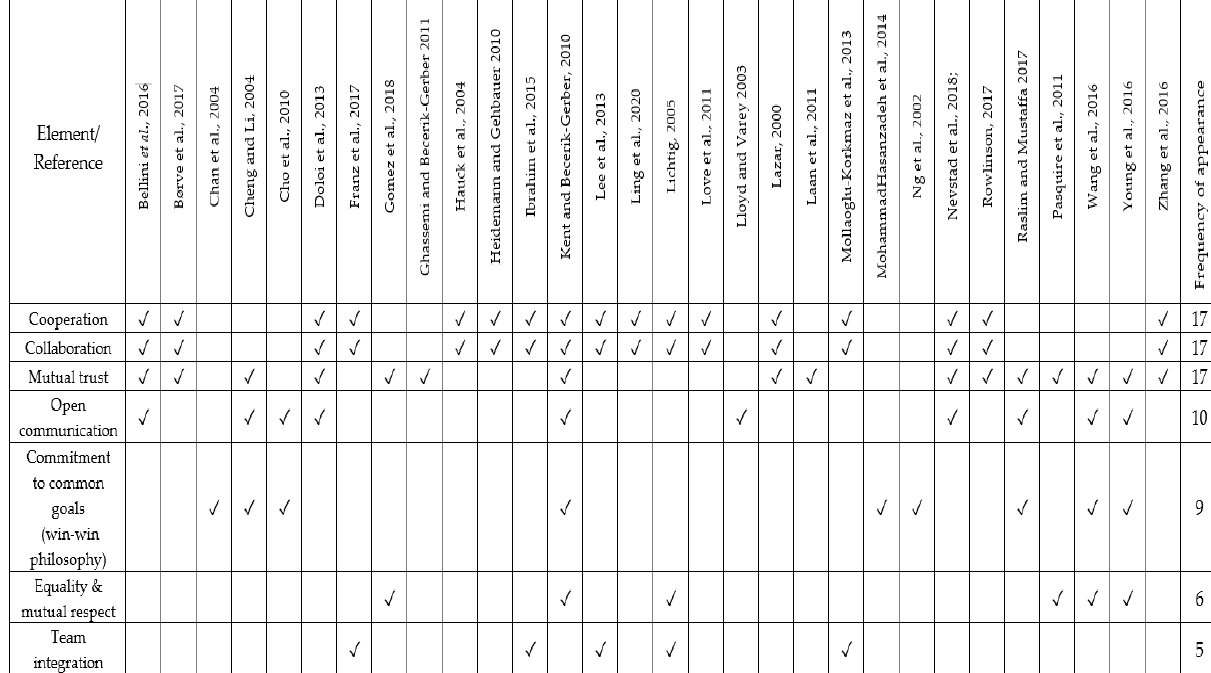
Figure 3. Behavioral elements of collaborative delivery models identified from the literature.